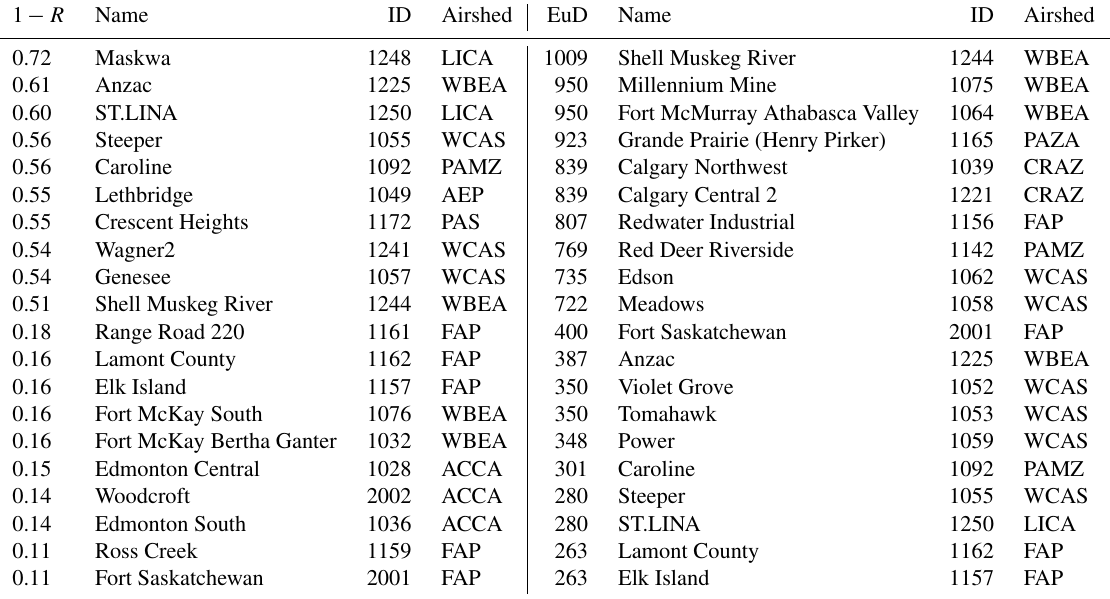
Table 1. Hourly NO 2 similarity ranking for the 1 − R and Euclidean distance (EuD) metrics. Note that stations at the bottom of the two columns are the most similar (hence one measure of their level of redundancy) with respect to each metric of dissimilarity. Here we show only the first 10 and last 10 items of the ranking; the full ranking can be consulted in Table